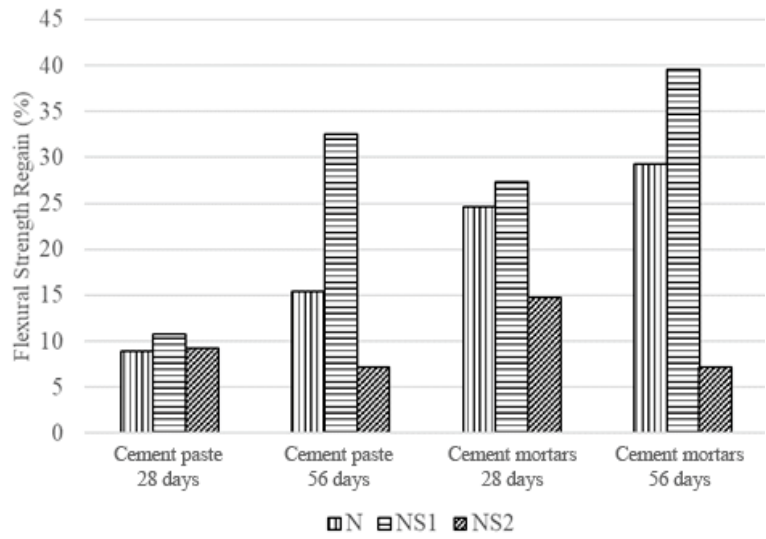
Figure 12. Flexural strength regains in cement paste and mortars after 28 and 56 days of incubation. The flexural strength regains results show that most of the self-healing for NS1-cement paste